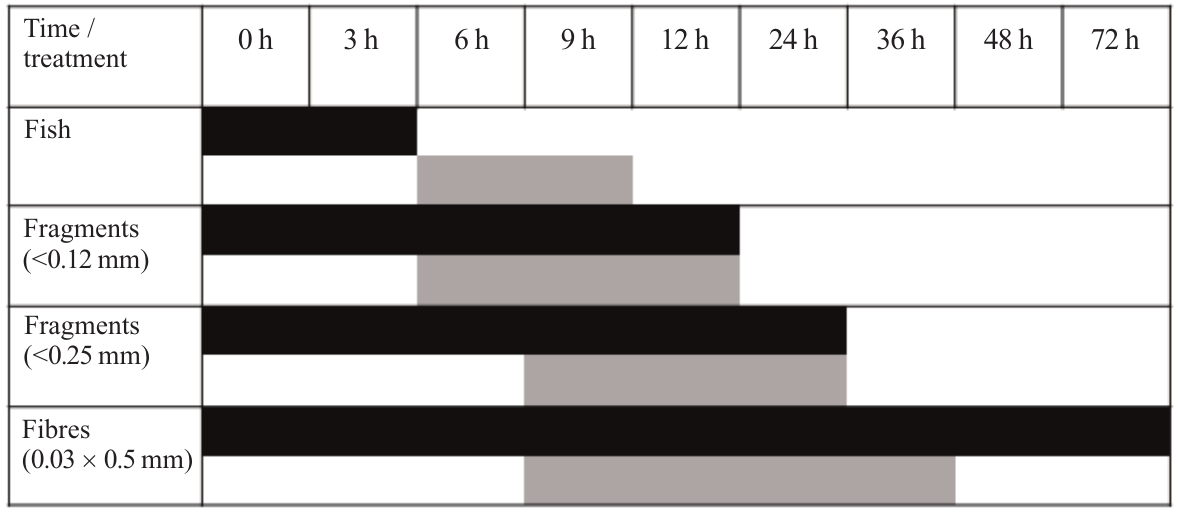
Fig. 1. Localization of food and particles in stomach (marked in black) and intestine (marked in